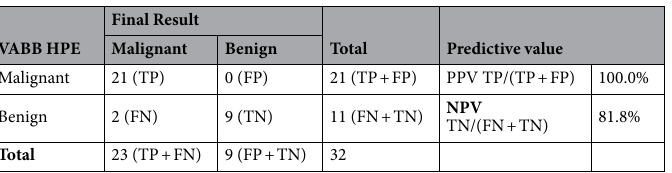
Table 5. The statistical analysis of VABB HPE vs Surgical HPE. Sensitivity TP/(TP + FN) = 91.3%. Specificity TN/(FP + TN) =